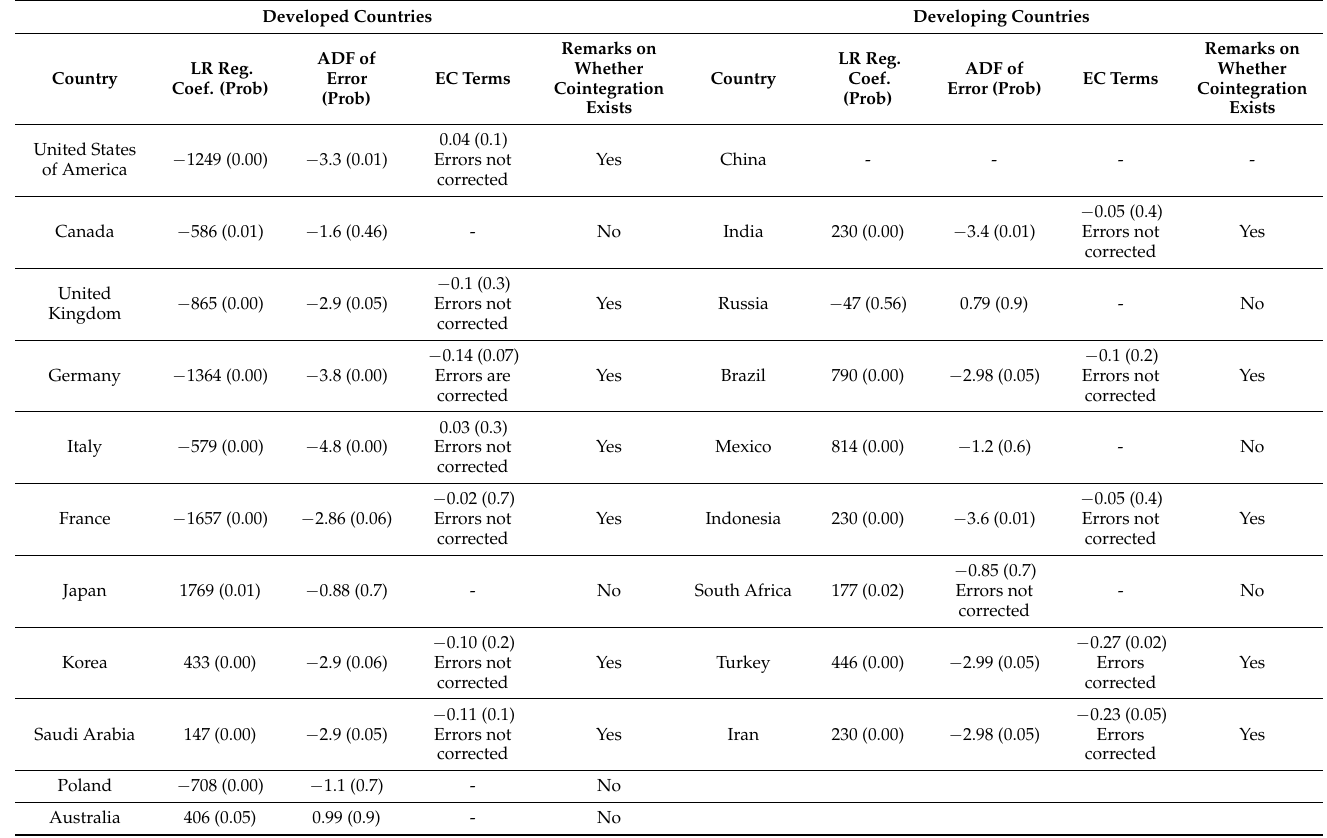
Table 3. Cointegration test results. Source: Author’s own